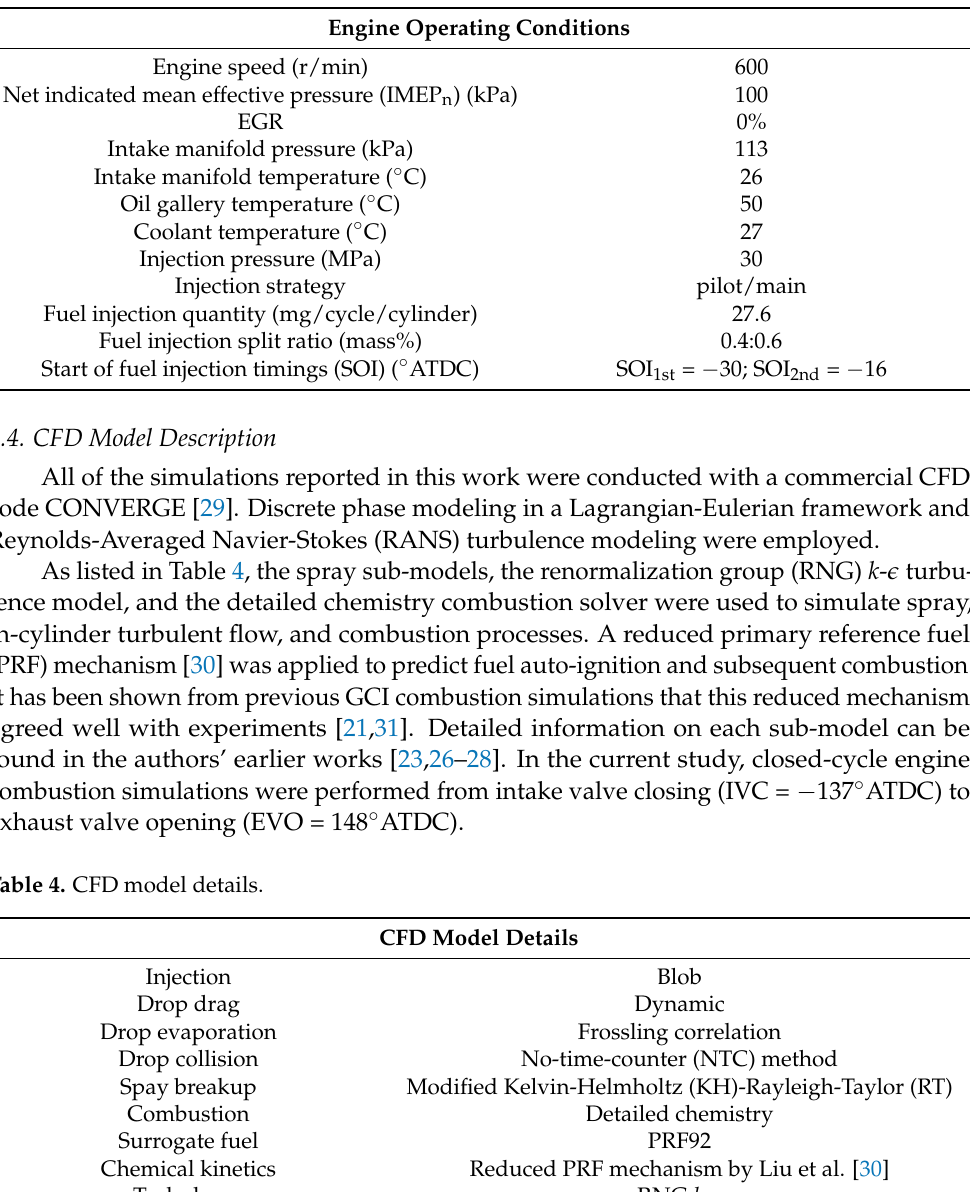
Table 3. Baseline cold idle conditions.